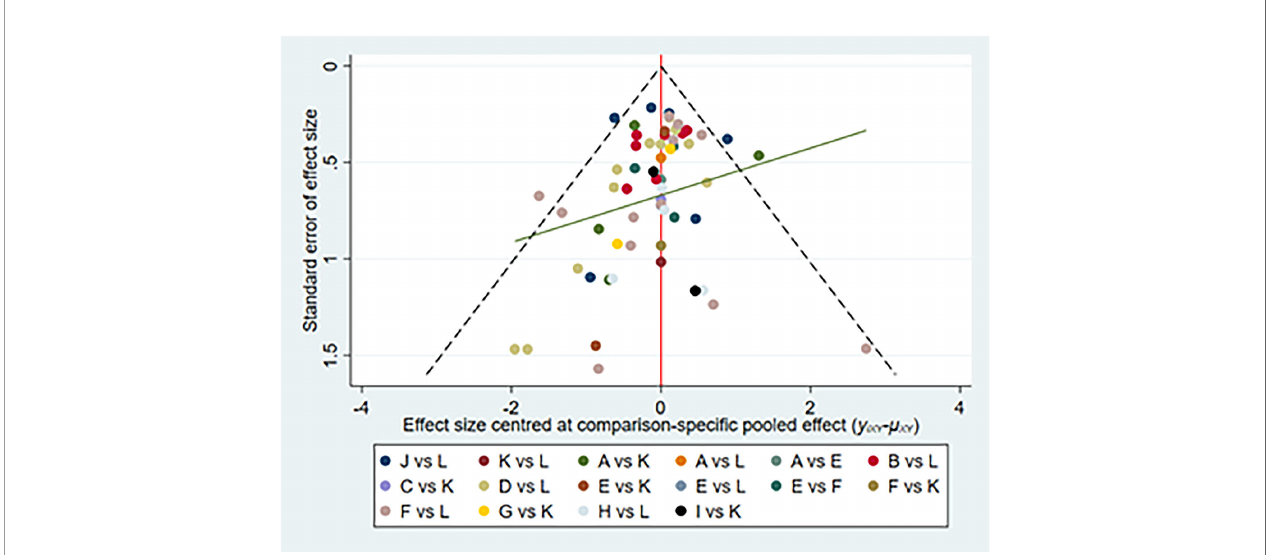
FIGURE 7 | Networkoffunnelplot for serious adverse events. A, adalimumab;B,adalimumab + DMARD;C, certolizumab;D,certolizumab + DMARD; F,etanercept; G, etanercept+ DMARD; H, golimumab;I, golimumab+ DMARD; J,in fl iximab; K,in fl iximab + DMARD;L,DMARD;DMARD, disease-modifying